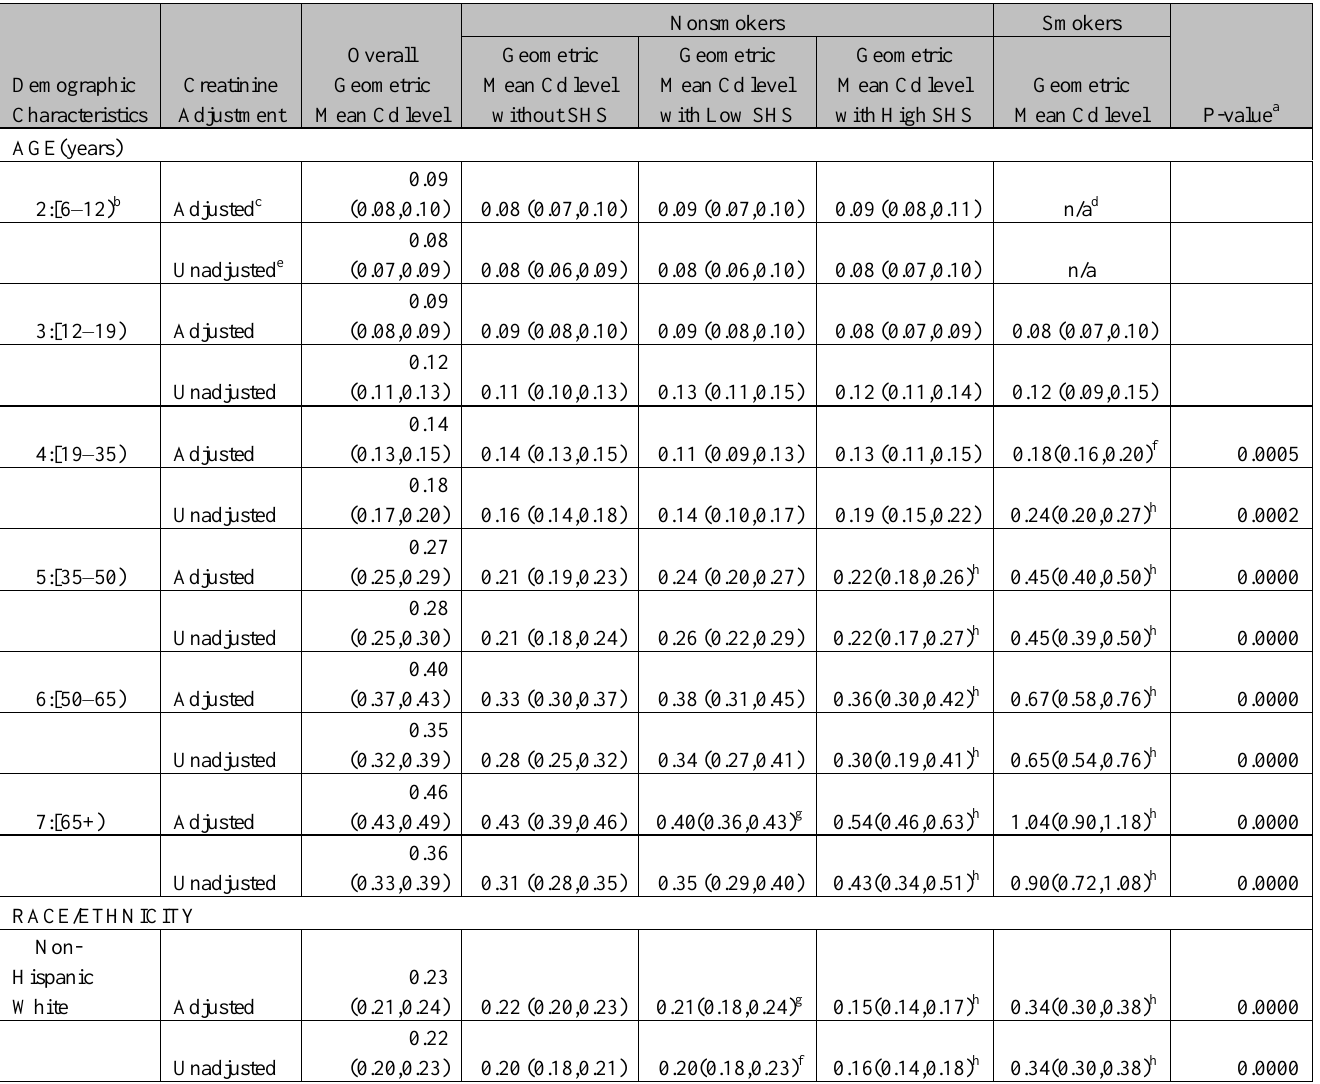
Table 3. Geometric Means and P-values Overall and by Level of Smoke Exposure and by Demographic Characteristics for Cadmium